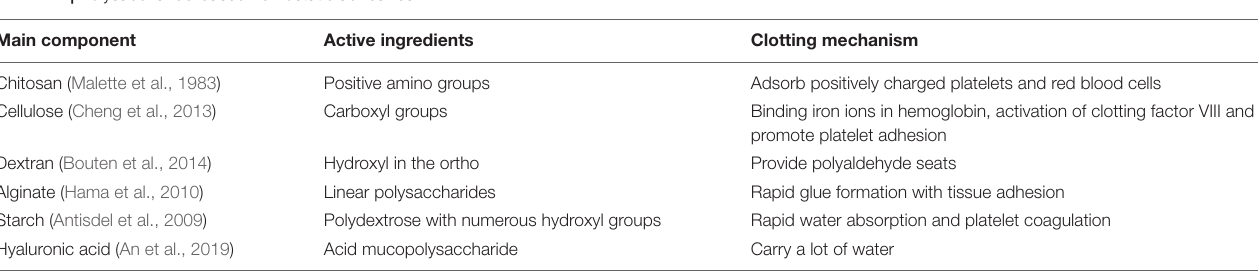
TABLE 2 | Polysaccharide-based hemostatic